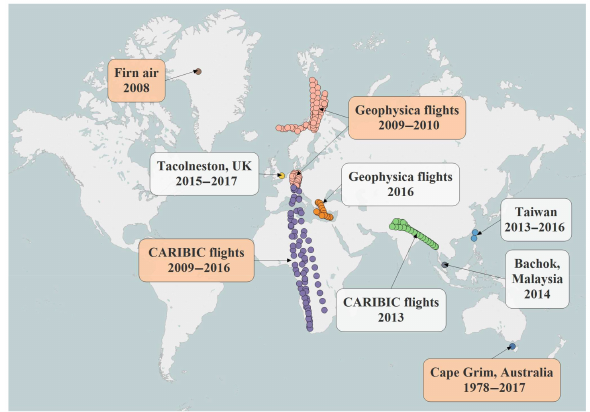
Figure 1. Sampling locations used in this study. Those locations that have been added since Laube et al. (2014) are in white. Those shaded orange featured in, or have been extended since, Laube et al.